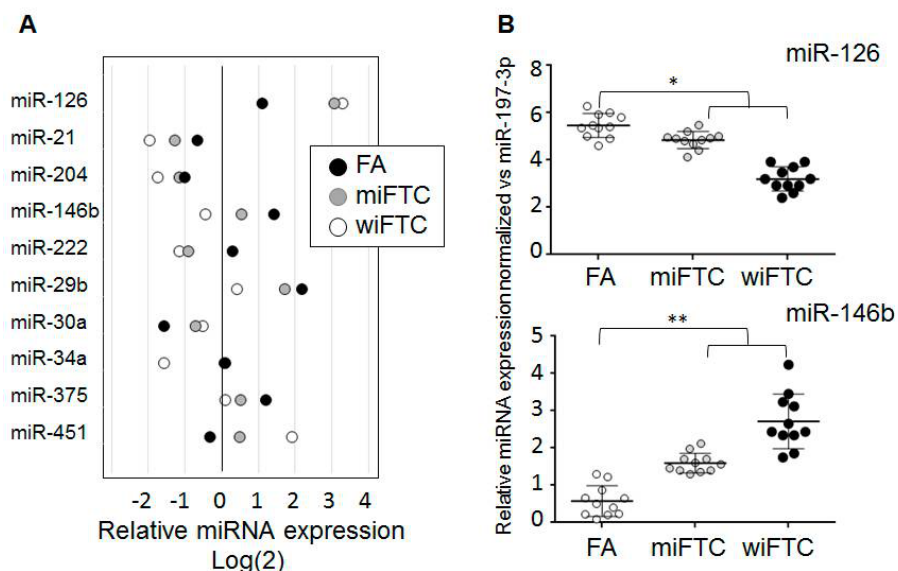
Figure 1. Profiling of 170 miRNA in samples of follicular adenoma (FA), miFTC and wiFTC. ( A ) Selected miRNAs with gradually altered expression in row of follicular adenoma (FA)—minimally invasive FTC (miFTC)—widely invasive follicular thyroid cancer (FTC) (wiFTC). RT-qPCR was performed with miRCURY LNA miRNA Focus PCR Panel using three pooled samples. Results RT-qPCR were normalized to global Ct mean and Log2 transformed. ( B ) Results of miR-126 and mir146b analyses by RT-qPCR in individual samples of FA, miFTC and wiFTC. Results RT-qPCR were normalized to miR-197-3p. Statistical significance was calculated using the one tailed Mann-Whitney U test and is indicated by * ( p < 0.05) and ** ( p < 0.005).